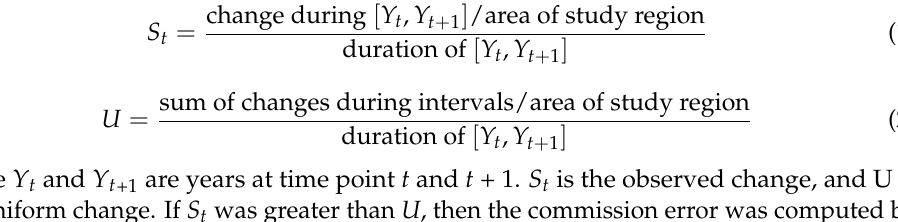
sum of changes during intervals / area of study region